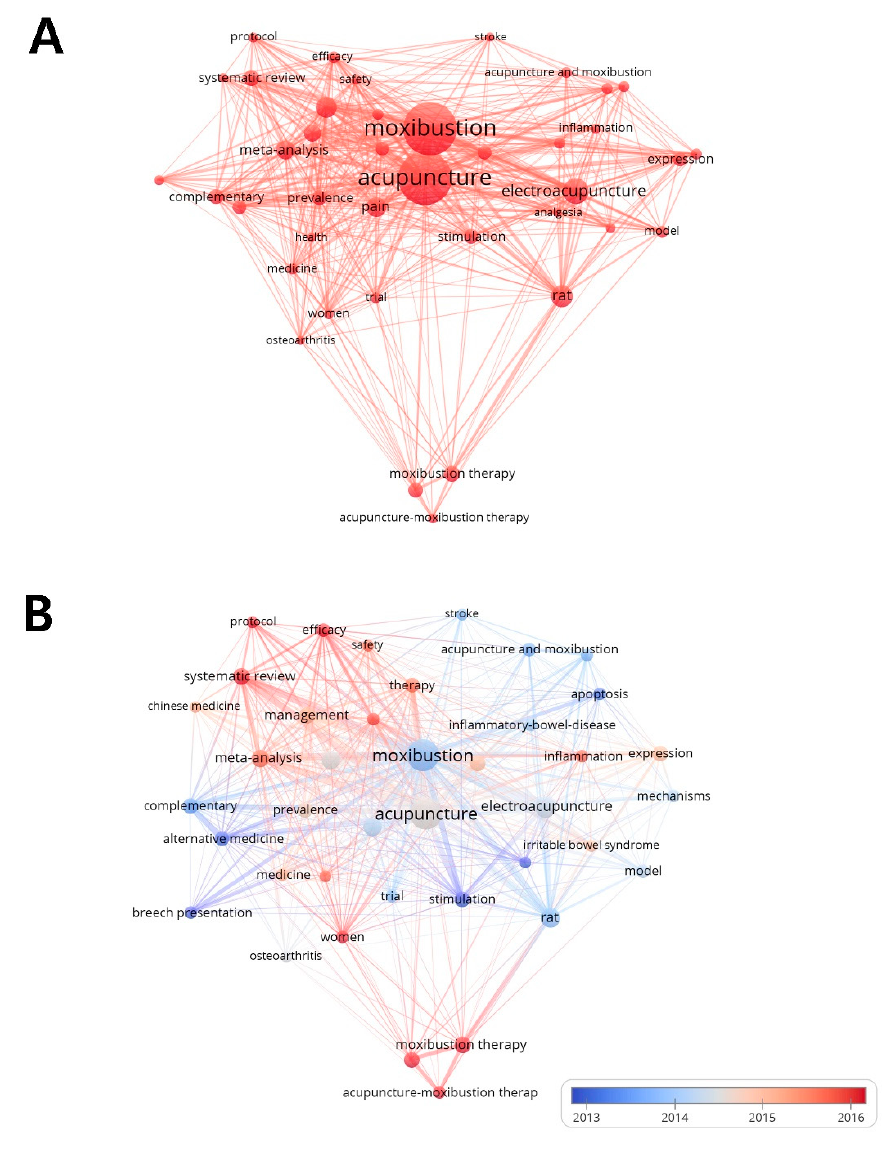
Figure 2. Analysis of the keywords that occurred more than 20 times in the title and abstract fields.